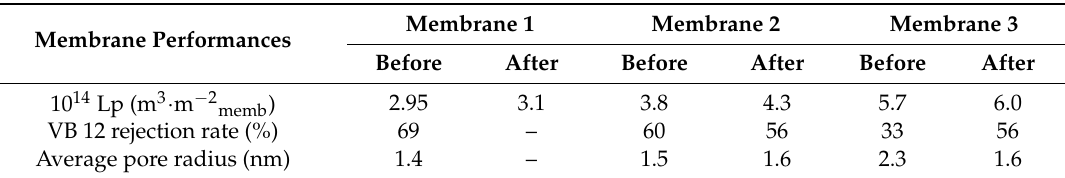
Table 3. Hydraulic permeabilities, rejection rate of Vitamin B12, and estimated mean pore radius before and after the alkaline treatment.